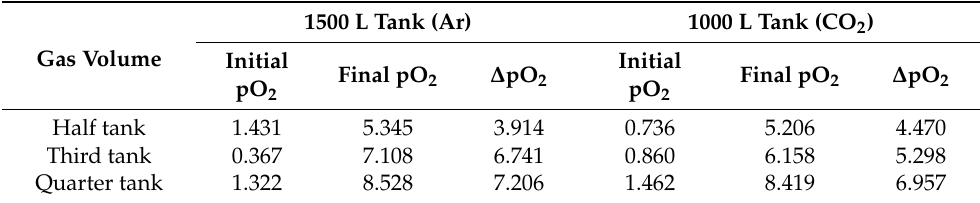
Table 7. Increase in the oxygen partial pressure (hPa) in the model wine during filling through the bottom valve in a previously purged tank with different inertization gases and volumes.